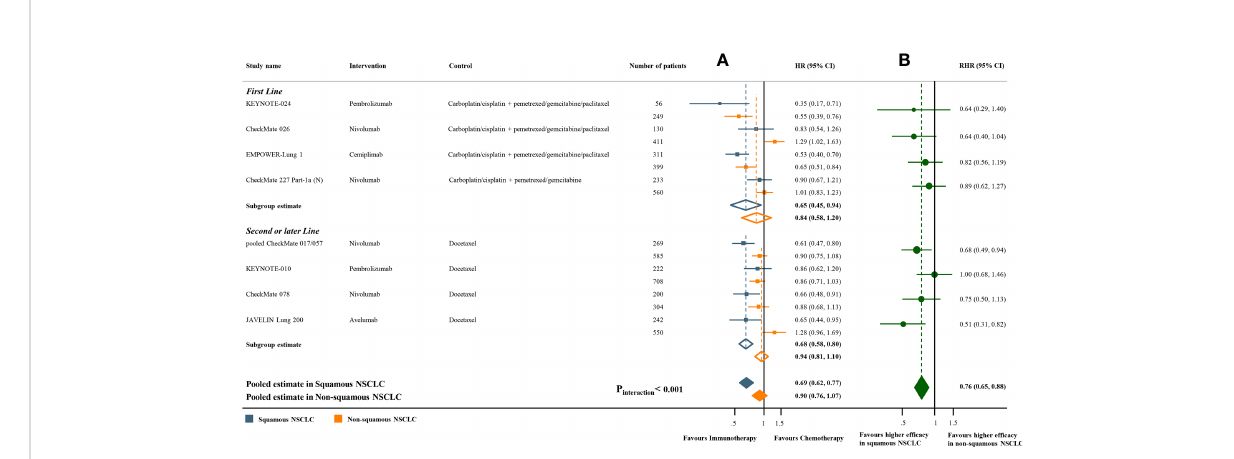
FIGURE 3 Progression-free survival bene fi ts of ICI monotherapy compared with chemotherapy in studies with paired subgroups. (A) HRs according to histology. (B) Trial-speci fi c ratios of the HR in SQ-NSCLC to the HR in non-SQ-NSCLC. ICI, immune checkpoint inhibitor; HR, hazard ratio; RHR, ratios of the HRs; CI, con fi dence interval.